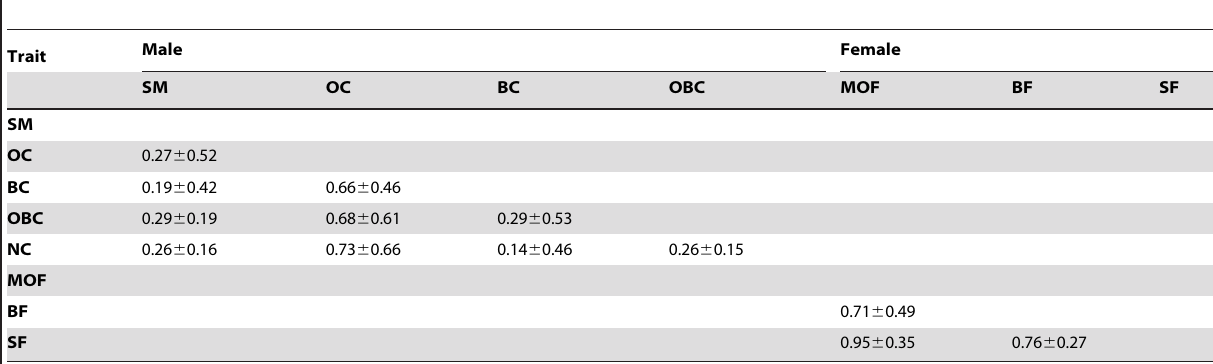
Table 6. Genetic correlations ( 6 s.e.) between expressions of body weight in male and female.